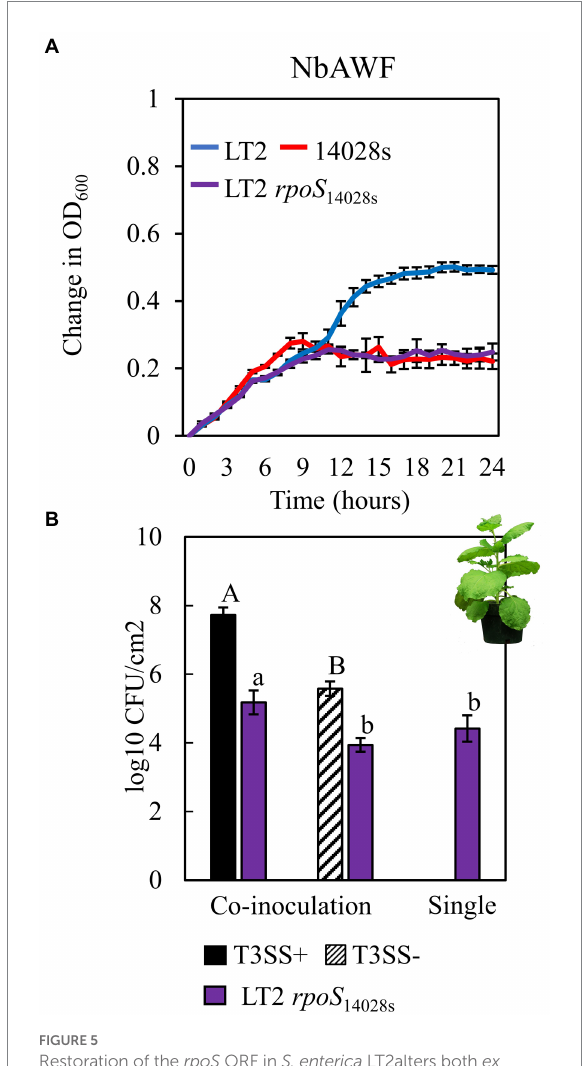
FIGURE 5 Restoration of the rpoS ORF in S. enterica LT2alters both ex planta and in planta phenotypes. (A) Growth curves of LT2 (blue), 14028s (red), and LT2 rpoS 14028s (purple) in N. benthamiana apoplastic wash fluid (NbAWF). Cultures were aliquoted into 5 replicate wells, incubated at 22 ° C, and the OD 600 was recorded every hour. Growth was measured as the average change in measured OD 600 with standard deviation error bars ( n = 5 wells). Two independent experiments were conducted with similar results. (B) Population of S. enterica LT2 rpoS 14028s in N. benthamiana, co-inoculated with P. syringae ( Pto ) with (T3SS+, black) and without (T3SS − , striped) a functional Type III Secretion System. Pto ∆ hopQ and Pto ∆ hrcC were used as T3SS+ and T3SS − respectively. Inocula were syringe-infiltrated at concentrations defined in Figure 1. Data are means ± SD ( n = 3 plants). Bacterial populations were measured as log colony forming units per cm 2 of leaf tissue (log 10 CFU/cm 2 ) 3 days post- inoculation. Data are means ± SD ( n = 3 plants). Different letters indicate significant differences (2-tailed t -test for each strain at p < 0.05). Three independent experiments were conducted with similar